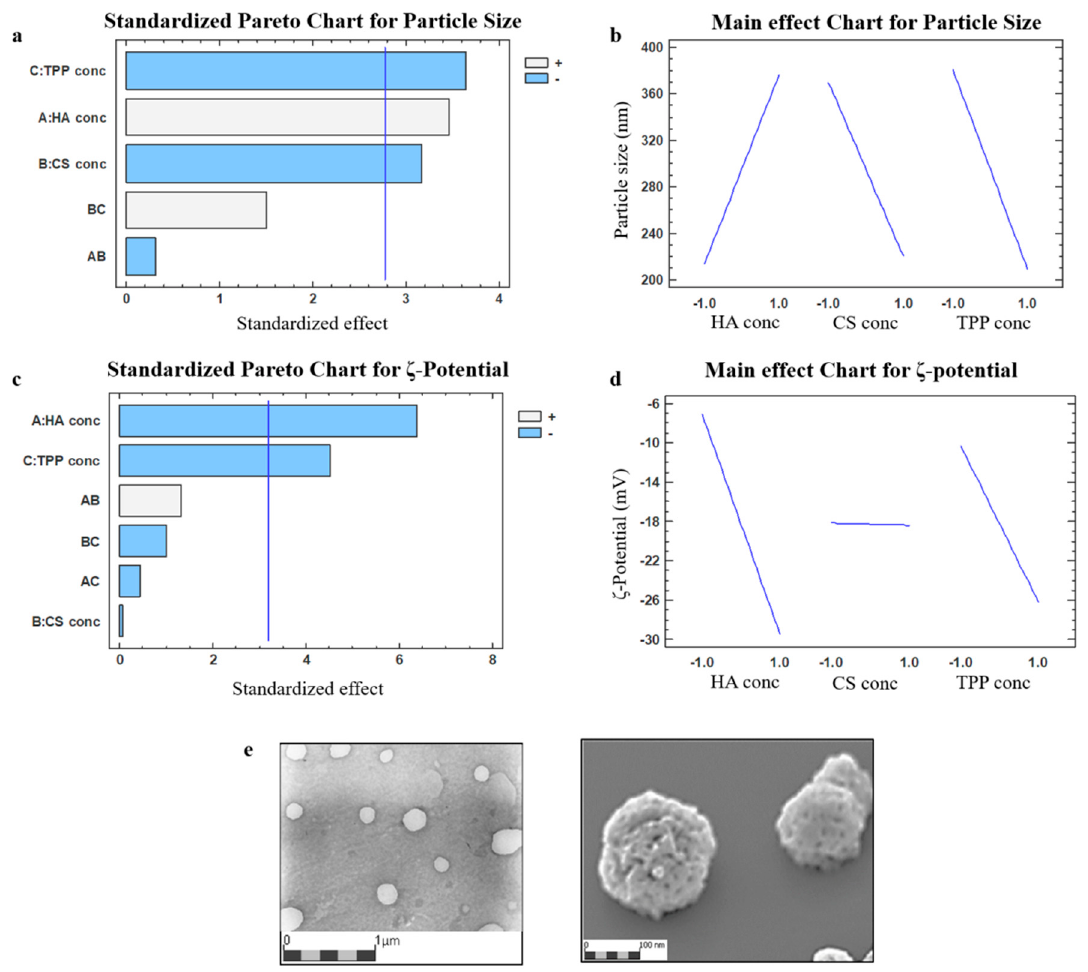
Figure 1. Pareto chart and main effect chart depicting the impacts by individual factors or two-factors interaction on nanoparticles (NPs) size ( a , b , respectively) and ζ potential ( c , d , respectively) in the two-level full factorial screening; ( e ) TEM (transmission electron microscope) and SEM (scanning electron microscope) photomicrographs of the hyaluronic acid (HA)/chitosan (CS)-pentasodium tripolyphosphate (TPP) NPs (DoE batch #B).